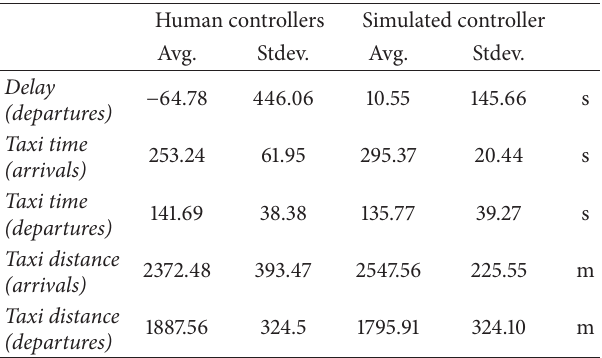
Table 1: Controller performance for EDDH “high traffic” scenario, 60 A/C per hour, 1h